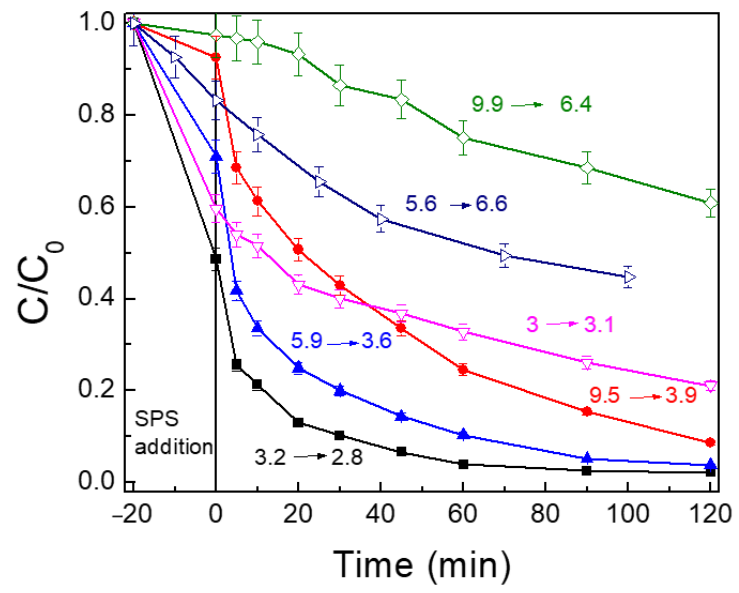
Figure 14. Effect of initial pH on 500 µ g/L SMX adsorption (open symbols, no SPS) and degradation (solid symbols, 500 mg/L SPS) with 100 mg/L biochar (RHB 850) in UPW. Initial and final pH values are noted on the graph.